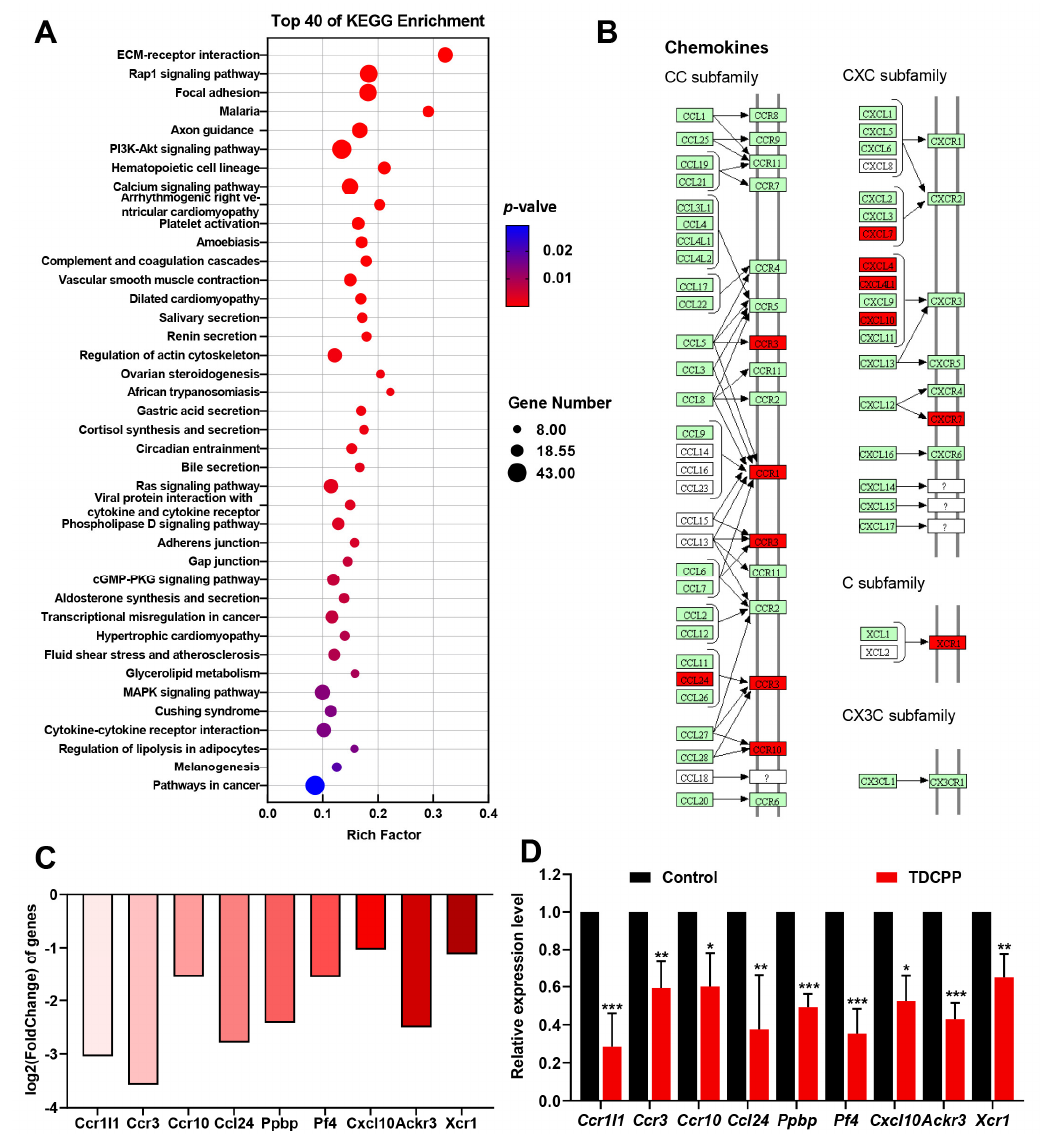
Figure 6. KEGG enrichment analysis and validation of gene expression of TDCPP vs. control DEGs. ( A ) The most significant p -values for the KEGG enrichment pathways were up- and downregulated by TDCPP vs. control. ( B ) Gene expression of chemokines in the cytokine–cytokine receptor interaction pathway. Red markers indicate downregulated genes. ( C ) The RNA sequencing results showed that the DEGs of chemokines in the cytokine–cytokine receptor interaction pathway in spleen tissue of TDCPP vs. control groups. ( D ) Validation of DEGs of chemokines in the cytokine–cytokine receptor interaction pathway in splenic tissues of TDCPP vs. control groups through qRT-PCR. * p < 0.05, ** p < 0.01, *** p < 0.001, compared with control group.